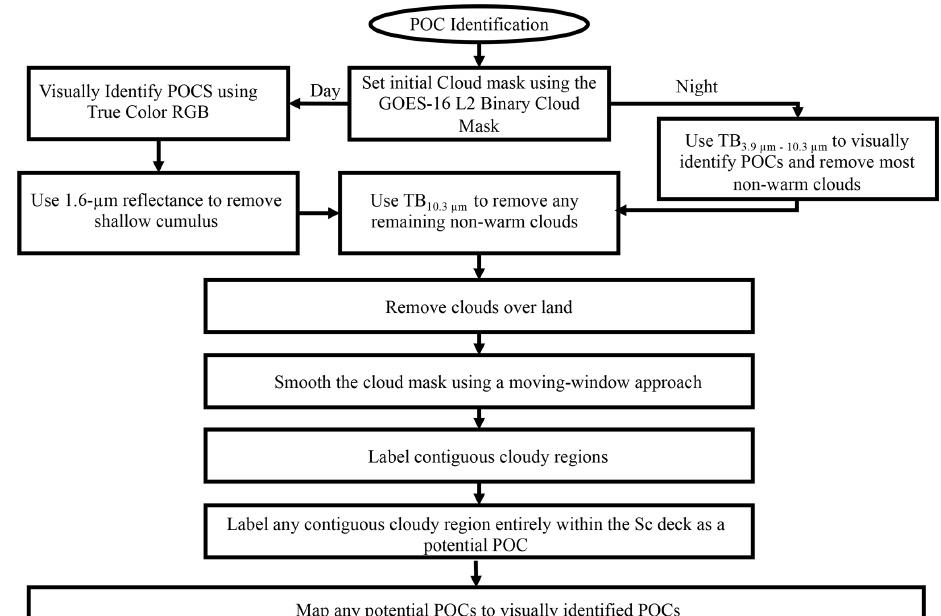
Figure 1. Flowchart of how POCs are